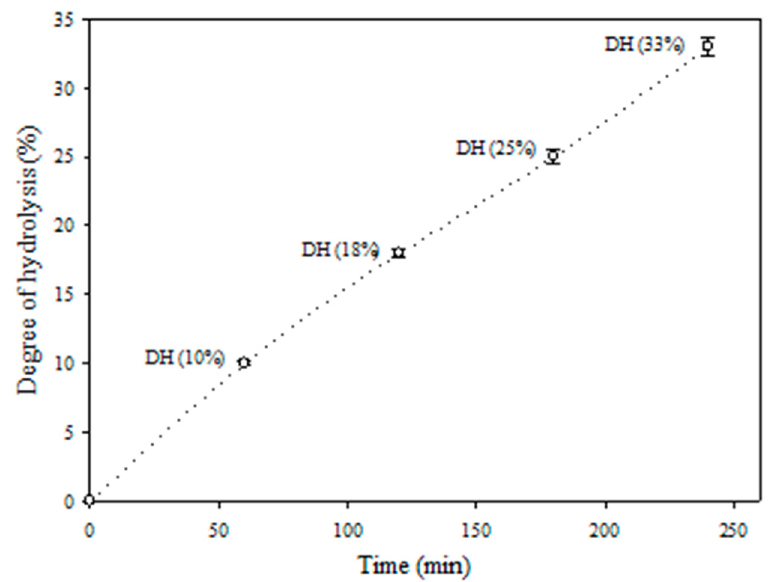
Figure 2. Changes in degree of hydrolysis during enzymatic hydrolysis of egg albumin by pepsin for 240 min.